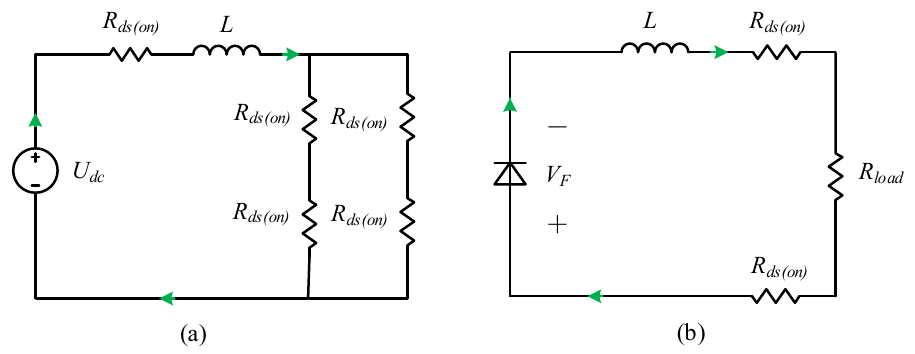
Figure 9. The equivalent circuit: ( a ) the charging state, and ( b ) the discharging states. Figure 8. The equivalent circuit: ( a ) the charging state, and ( b ) the discharging